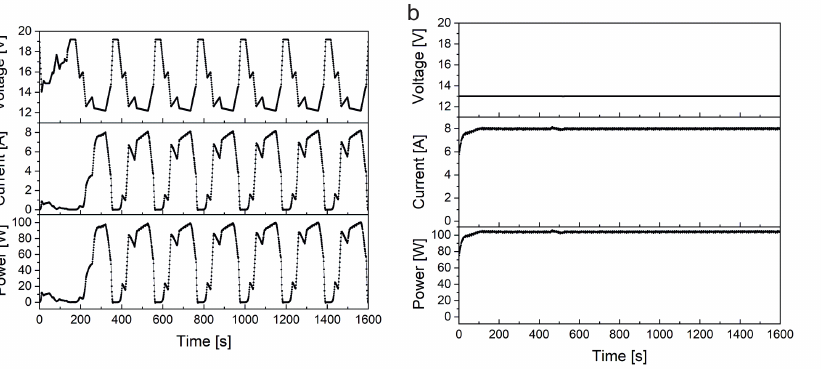
Figure 7. ( a ) Dynamic load cycle as adapted from the “high” and “extra high” sections of the WLTP test cycle. The depicted loop was repeated for 14 times and applied to a 100W fuel cell stack. ( b ) First part of the continuous high load cycle applied to a 100W fuel cell stack. The high load was applied for approximately 6 hours. Note that in both test schemes the voltage was set by the electrochemical workstation/potentiostat (i.e., potentiostatic control), while the corresponding current was measured. The power was calculated from both